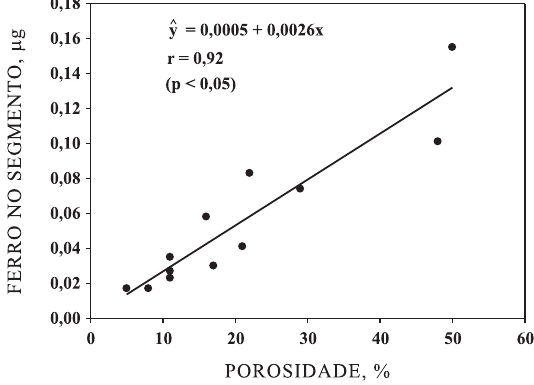
Figura 5. Relação entre a porosidade e a quantidade de ferro em segmentos de raízes adventícias de dois genótipos de arroz (IRGA 423 e 424), mantidos em ambiente com aeração e